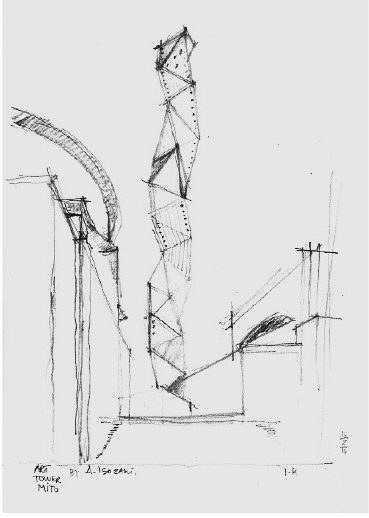
Figure 1. Sketch for Mito Art Tower, 1986.